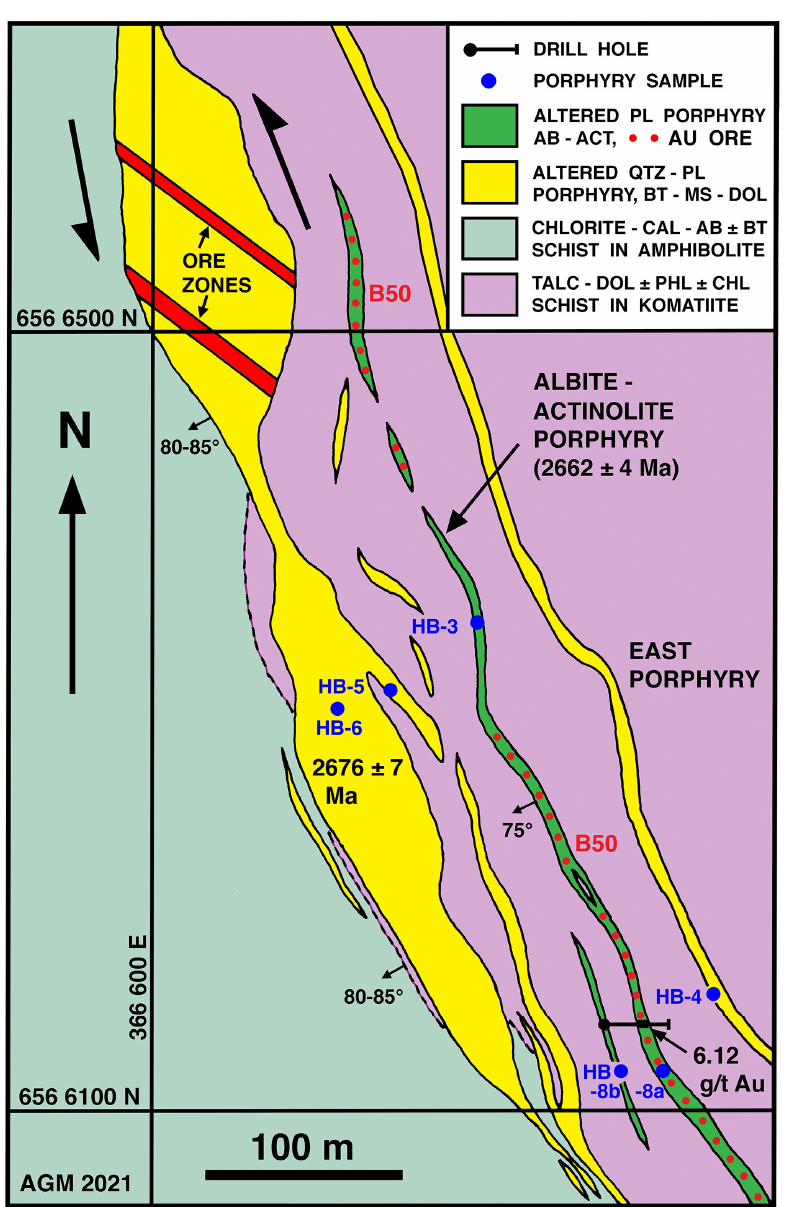
Figure 4. Surface geologic map (+355 m) of the Hampton Boulder part of the New Celebration deposit (modified from [38]) showing the porphyry dykes dated using zircons from samples HB-5 and HB-8a. Gold ore is bound to the intrusive contacts of all dykes except the East Porphyry. Two steeply dipping ore zones crossing the northern boudin of the main dyke indicate sinistral movement. The B50 ore zone and gold grade in the Albite-Actinolite Porphyry are from [6]. Minerals: actinolite (act), albite (ab), calcite (cal), chlorite (chl), dolomite (dol), phlogopite (phl), plagioclase (pl), pyrite (py), quartz (qtz). The UTM coordinates are MGA 1994.